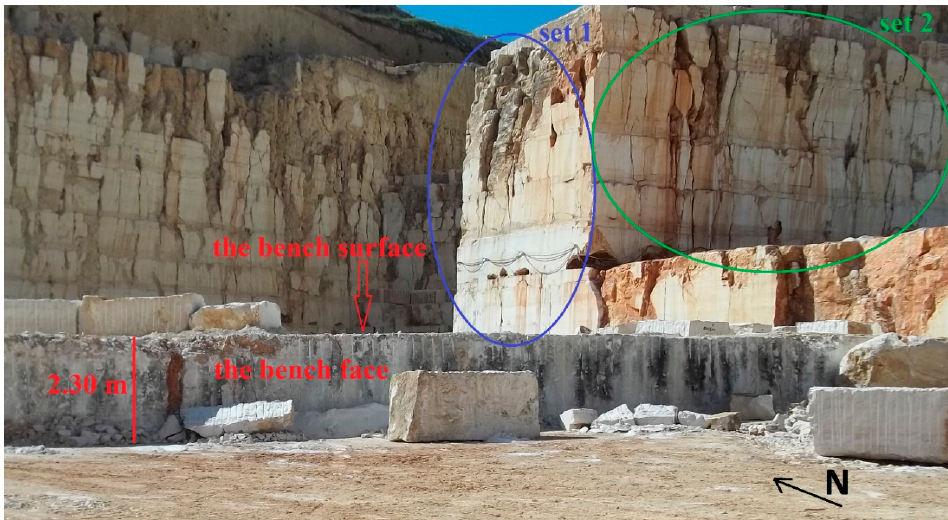
Figure 2. A view of the studied bench (under the arrow) highlighting the two sets of out-cropping fractures in two large normal rock faces. The orientation of the rock face, where Set 2 is highlighted in the figure, is parallel to the studied bench face.